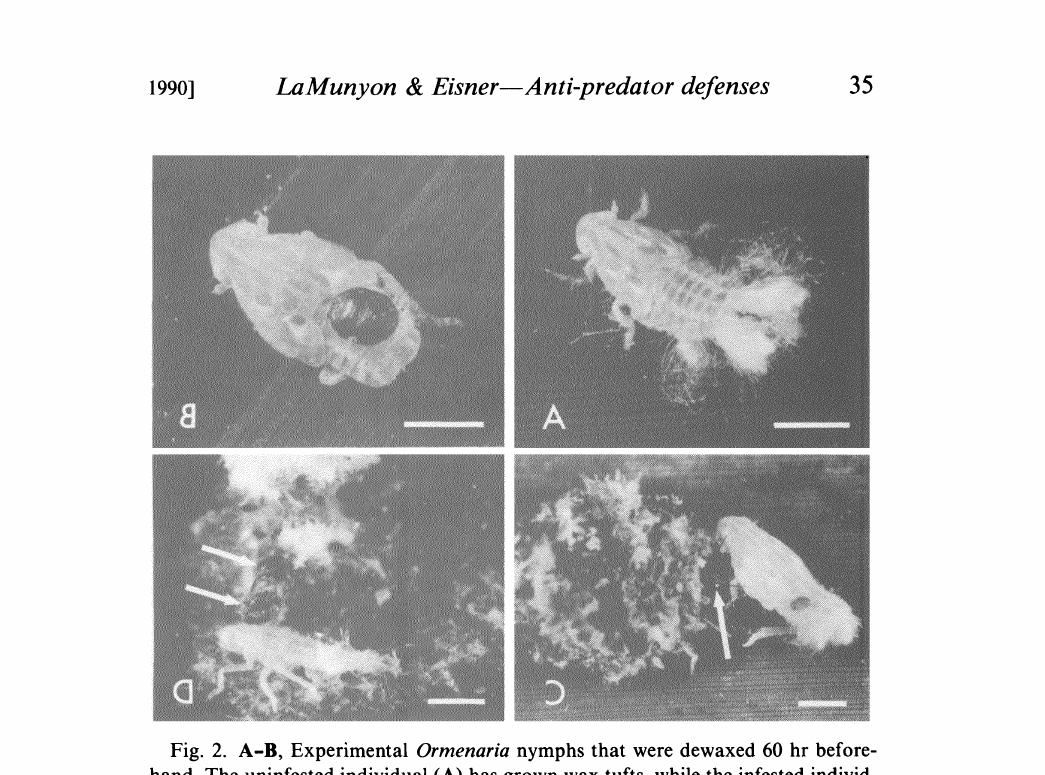
Fig. 2. A--B, Experimental Ormenaria nymphs that were dewaxed 60 hr before- hand. The uninfested individual (A) has grown wax tufts, while the infested individ- ual (l) has not. Details in text. C, Trash-carrying chrysopid larva (Ceraeochrysa smithi) feeding on an infested nymph; the small mite is visible on the nymph’s abdo- men; arrow denotes head of chrysopid. D, C. smithi larva feeding on a nymph’s parasitic mite; the upper and lower arrows denote respectively the chrysopid’s head and the mite. Bar